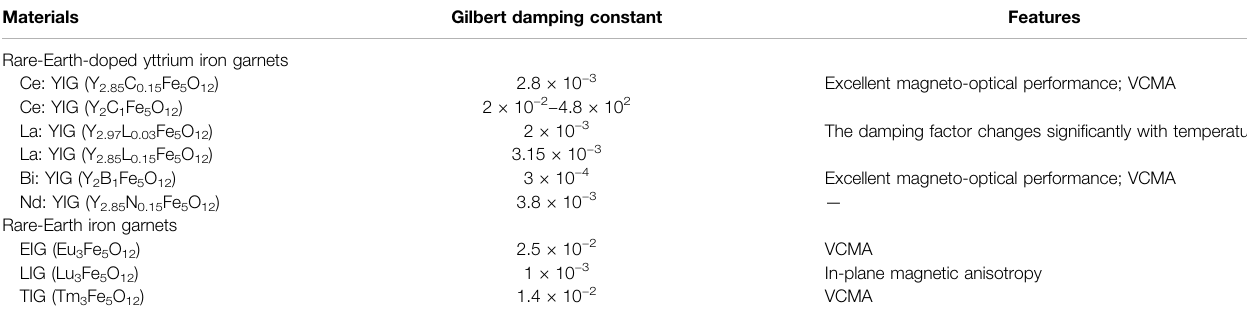
TABLE 3 | Gilbert damping constant and other magnetic properties of YIG fi lms modi fi ed by rare Earth elements. Materials Gilbert damping